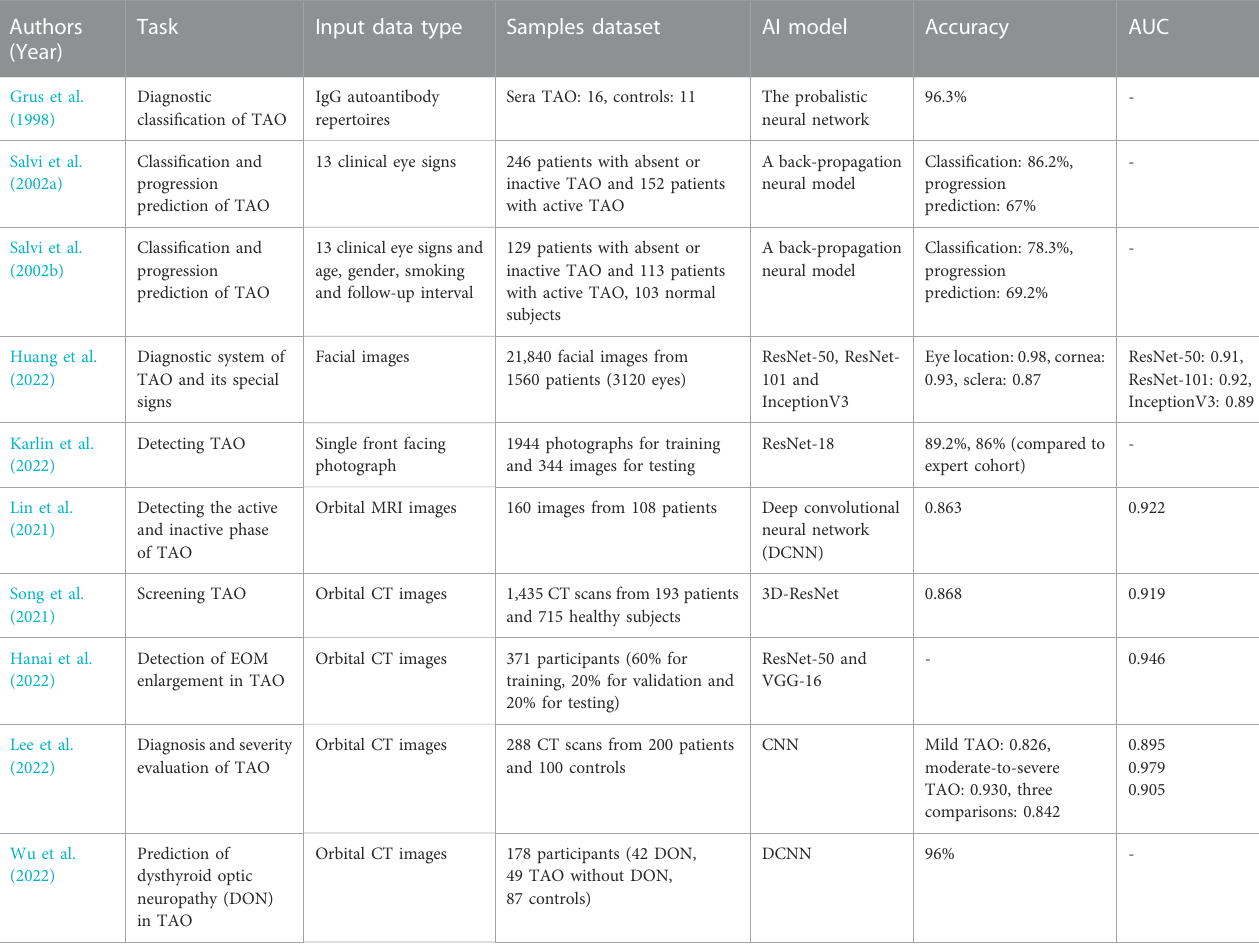
TABLE 1 AI algorithms in diagnosis and grading of